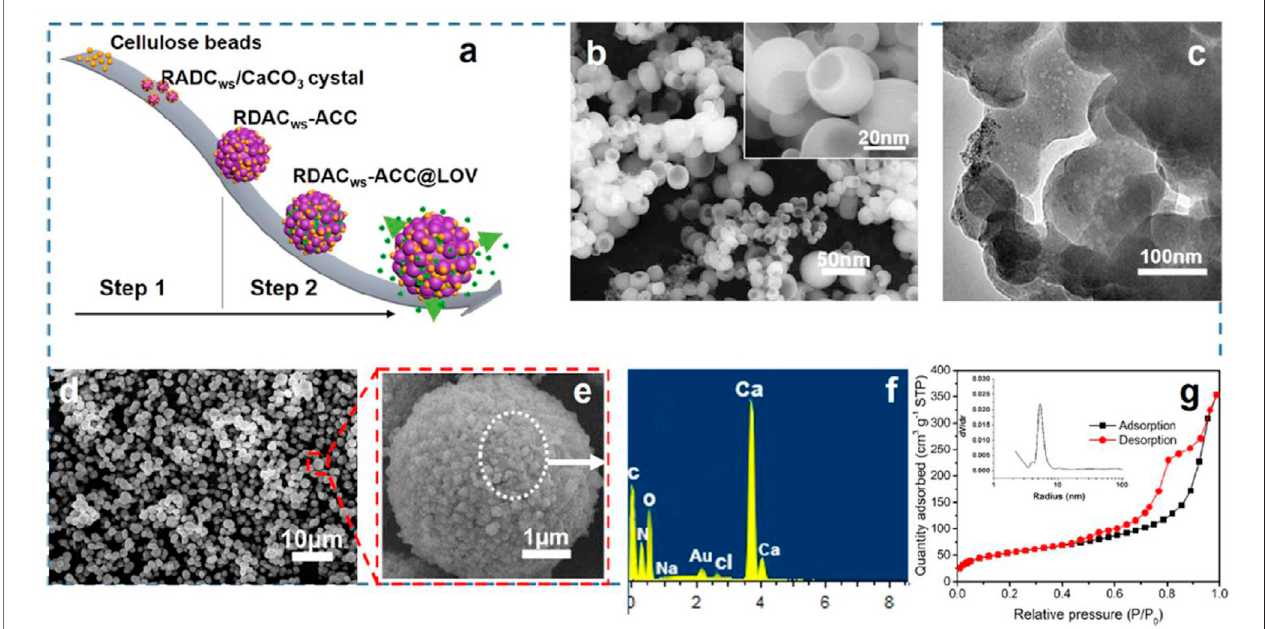
FIGURE3|(A) Schematicillustrationforthepreparation ofCaCO 3 microspheresanddrugloadingand releaseprocedures, (B) Thescanningelectronmicroscopy (SEM) image of the hollow cellulose-based NPs (DACws after aging for 10 days at 60 ° C) and the corresponding magni fi cation diagram (inset), (C) the transmission electron microscopy (TEM) image of the hollow cellulose-based NPs, (D) the SEM image of CaCO 3 microspheres with hollow cellulose-based NPs as the template, (E)